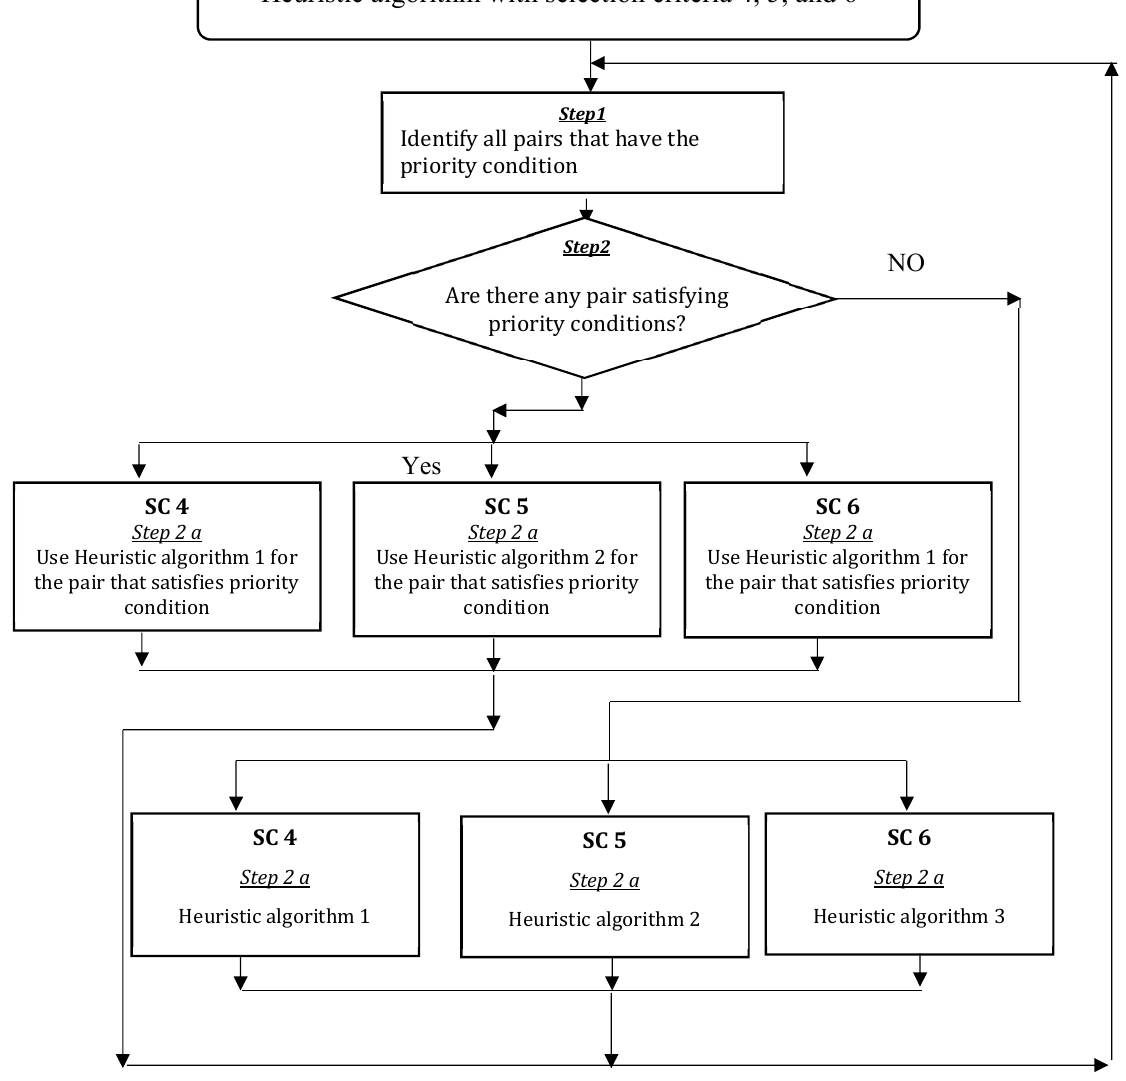
Fig. 3. Flowchart of the heuristic algorithm with SC 4, 5, and 6 adopted from (Yu & Egbelu,